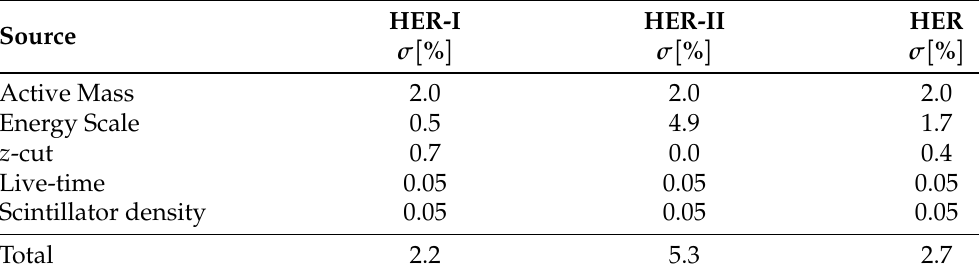
Table 7. Relevant sources of systematic uncertainties and their contribution to the measured interac- tion rate of 8 B solar neutrinos in the Borexino Phase I+II analysis in HER-I, HER-II, and combined HER = HER-I + HER-II energy